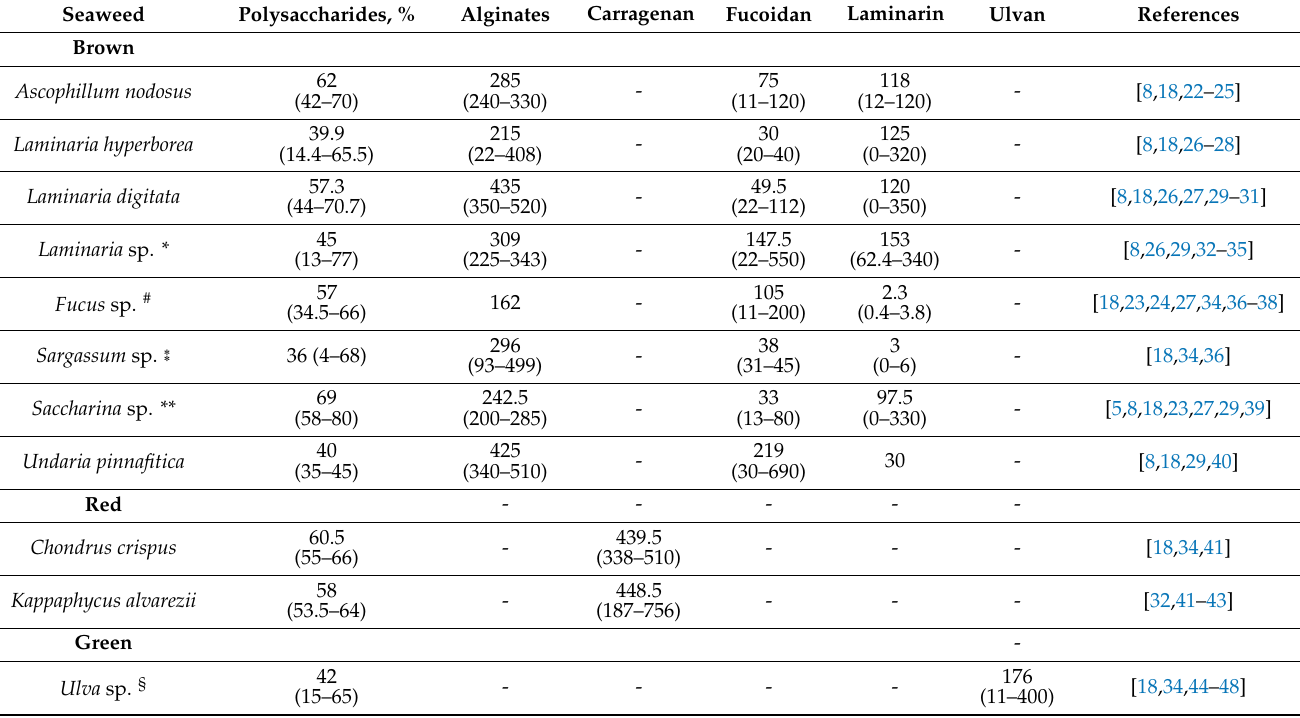
Table 2. Polysaccharides composition of brown, red, and green seaweed (g kg −1 DM) 1 .